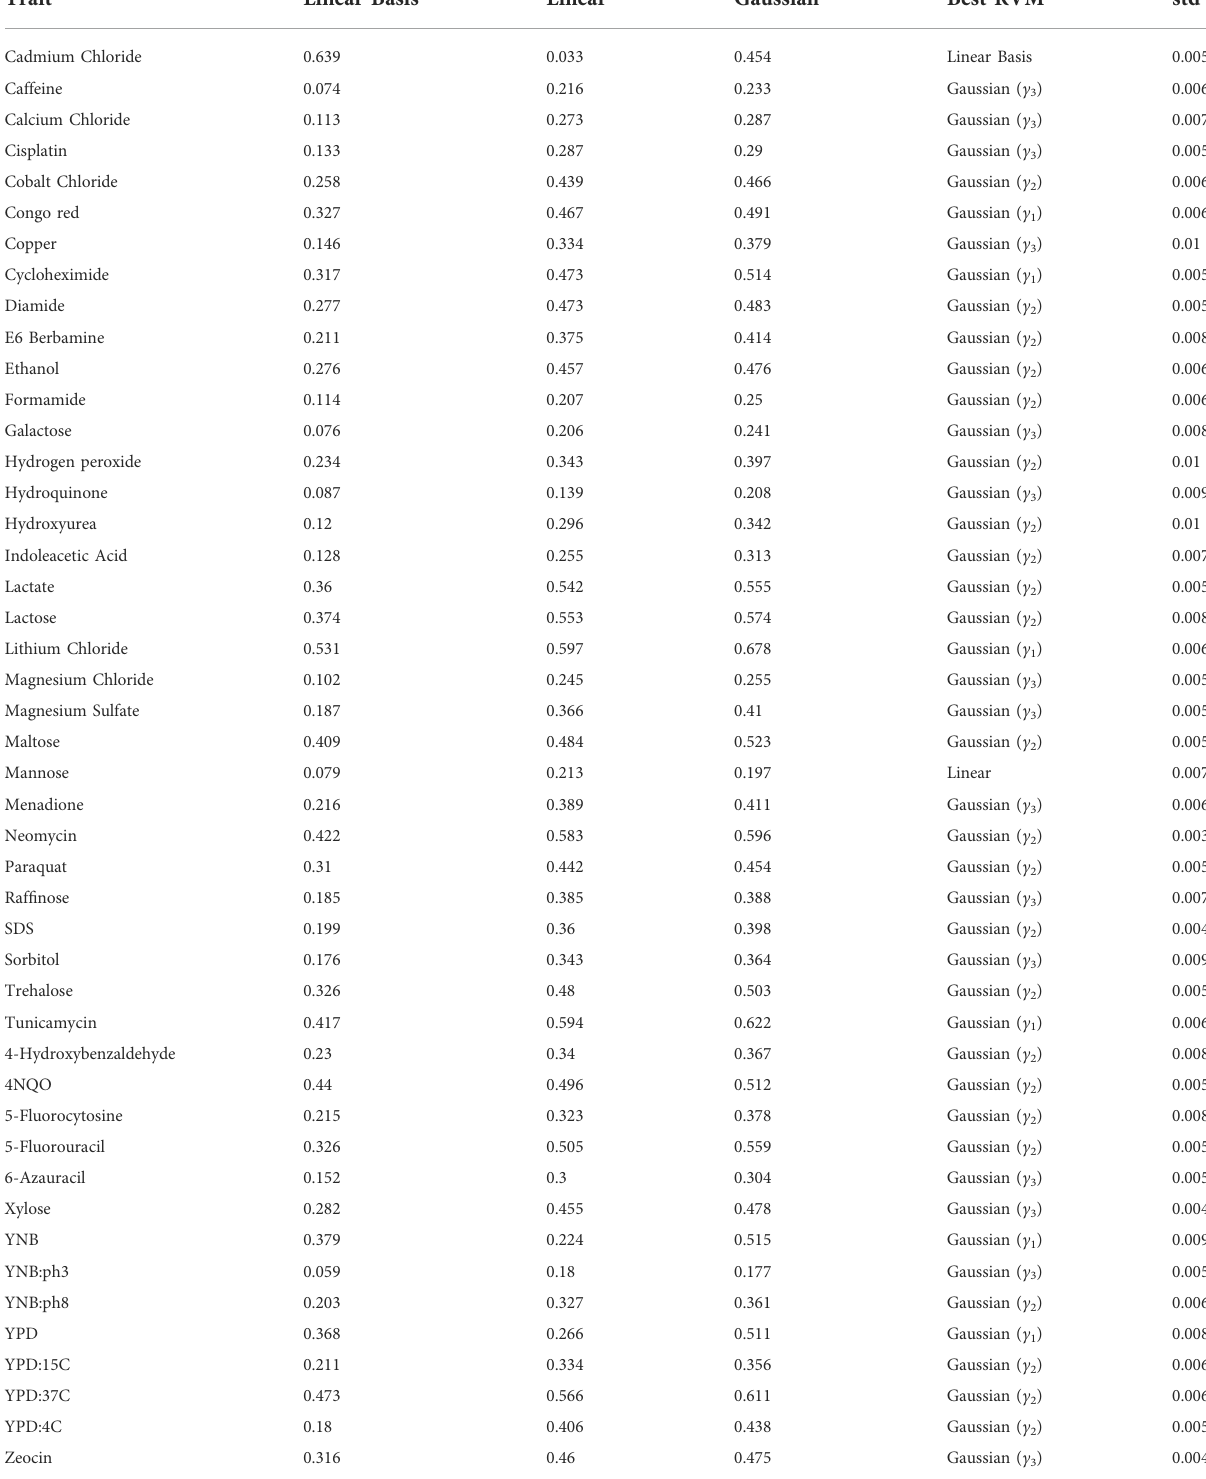
TABLE 1 Coef fi cient of determination ( R 2 ) and standard deviation of the best performing model (std) of RVM predictions among the 46